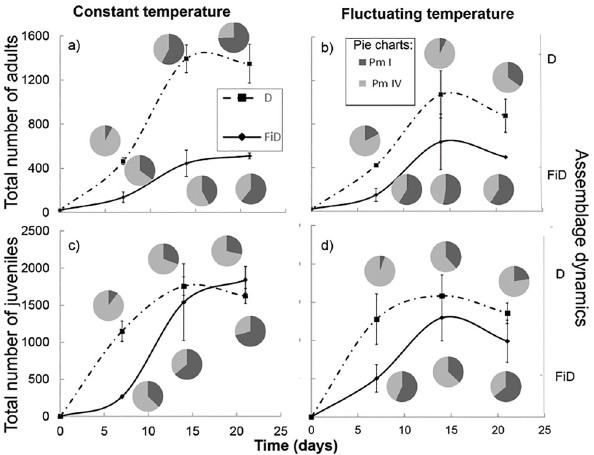
Fig 2. Total number of nematodes (adults: a + b, juveniles: c + d) over time in the different temperature treatments (constant temperature: a + c, fluctuating temperature: b + d) with assemblage dynamics at the different sampling times (three pie charts correspond with following time moments: 7, 14 and 21 days): upper pie charts for the D treatment (Pm I and Pm IV with interspecific interactions), lower pie charts are the dynamics in the FiD treatment (Pm I and Pm IV without interspecific interactions).